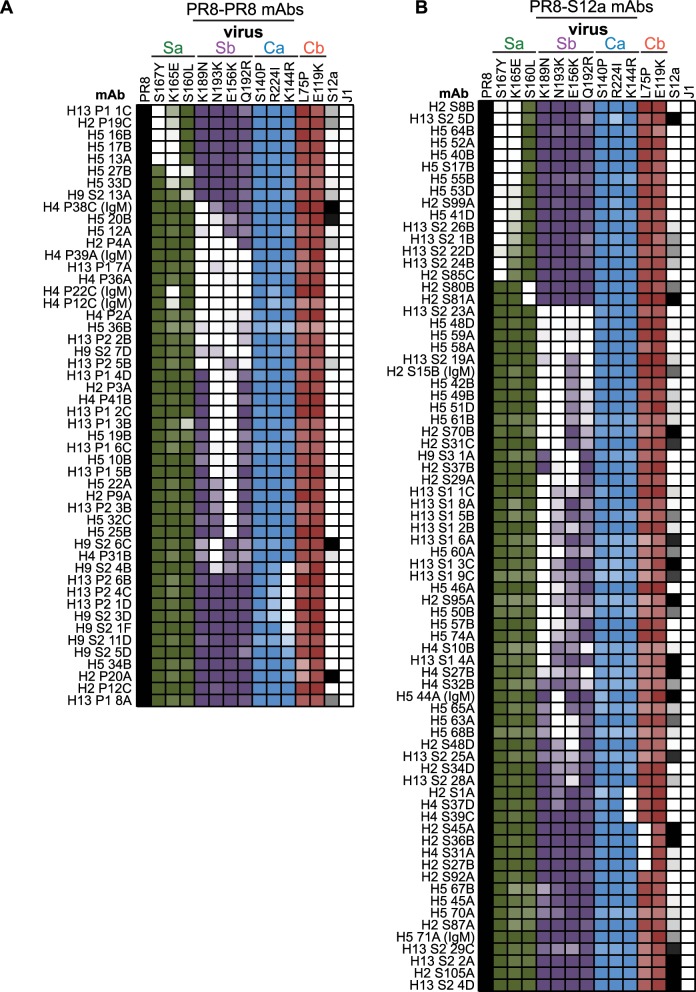
Fine specificity of mAbs elicited by sequential H1N1 exposure.(A, B) mAbs created from PR8 pre-exposed mice that were boosted either with PR8 (A) or S12a (B) were tested for binding to a panel of viruses by ELISA. We first completed a dose titration of each mAb on ELISA plates coated with PR8. We determined the lowest concentration of each mAb at which PR8 ELISA signal was within 90% of Bmax, and we tested this mAb concentration against all of the mutant viruses. The shade of color in each square is relative to the percentage of binding to that virus compared to PR8 binding with the darkest color being 100% and white being 0%. The coloring scheme (Sa = green, Sb = purple, Ca = blue, Cb = red) matches the coloring scheme of the HA structure shown in Fig 1. mAbs are IgG unless otherwise noted.